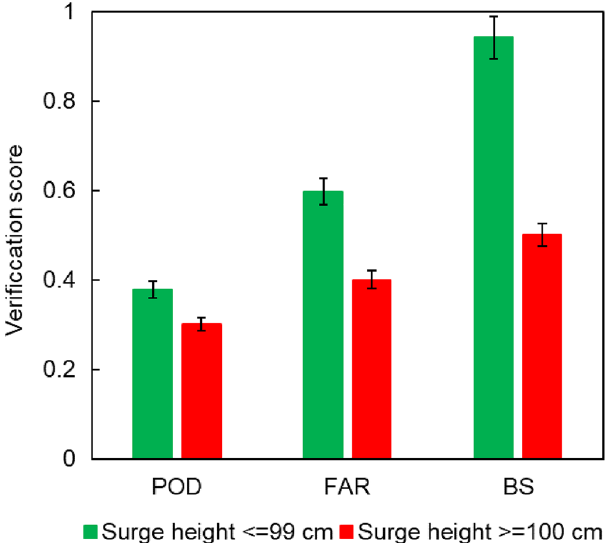
Figure 4. Verification scores for SSHPI estimated storm surges. Error bars show two-sided 95% confidence intervals.